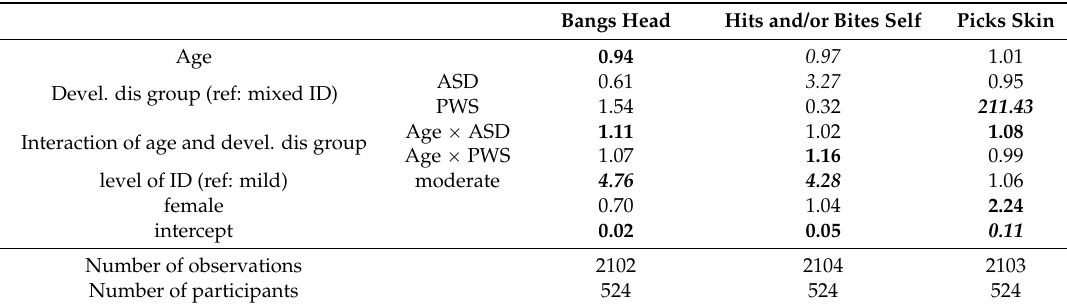
Table 2. Random effects logistic